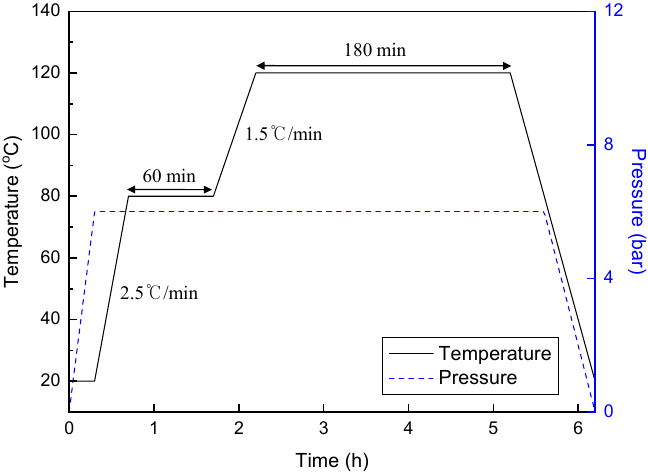
Figure 6. Curing cycle for the composite bogie using an autoclave.